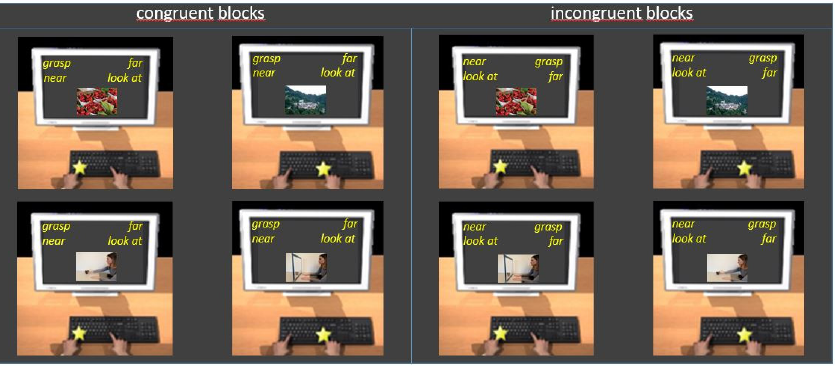
Figure 1. Examples of trials in congruent ( left panel ) and incongruent ( right panel ) blocks of Experiment 1. Participants were asked to press the E key with their left hand, when the category to which the image belongs was written at the top left, and to press the I key with their right hand, when it was written at the top right (see the text for details). The order of the action categories blocks (Blocks 1 and 5) and the combined blocks (Blocks 3 + 4 and Blocks 6 + 7) was counterbalanced across subjects. That is, half of the participants (Order 1) administered the blocks in the order just outlined, whereas the other half (Order 2) completed the task with Block 1, Block 3, and Block 4 switched with Block 5, Block 6, and Block 7 (Figure 2). Figure 2. S tructure of the seven blocks in the IAT administered to the two groups of participants (Order 1, Order 2) in Experiment 1 (see text for details). Response times and errors were collected online through the Project Implicit research platform (https://implicit.harvard.edu). Response time is the time from the onset of a sin ‐ gle stimulus to the categorization of that stimulus. 2.2. Data Analysis Data were analyzed according to the recommended IAT algorithm described by [46]. That is, we computed the D score for each participant. The D score [46] is a variation of Cohen’s d calculation of effect size used to measure the association strength between cat ‐ egories in the IAT. Research showed that the recommended IAT algorithm strongly out ‐ performs, in terms of psychometric proprieties, the conventional procedures often used